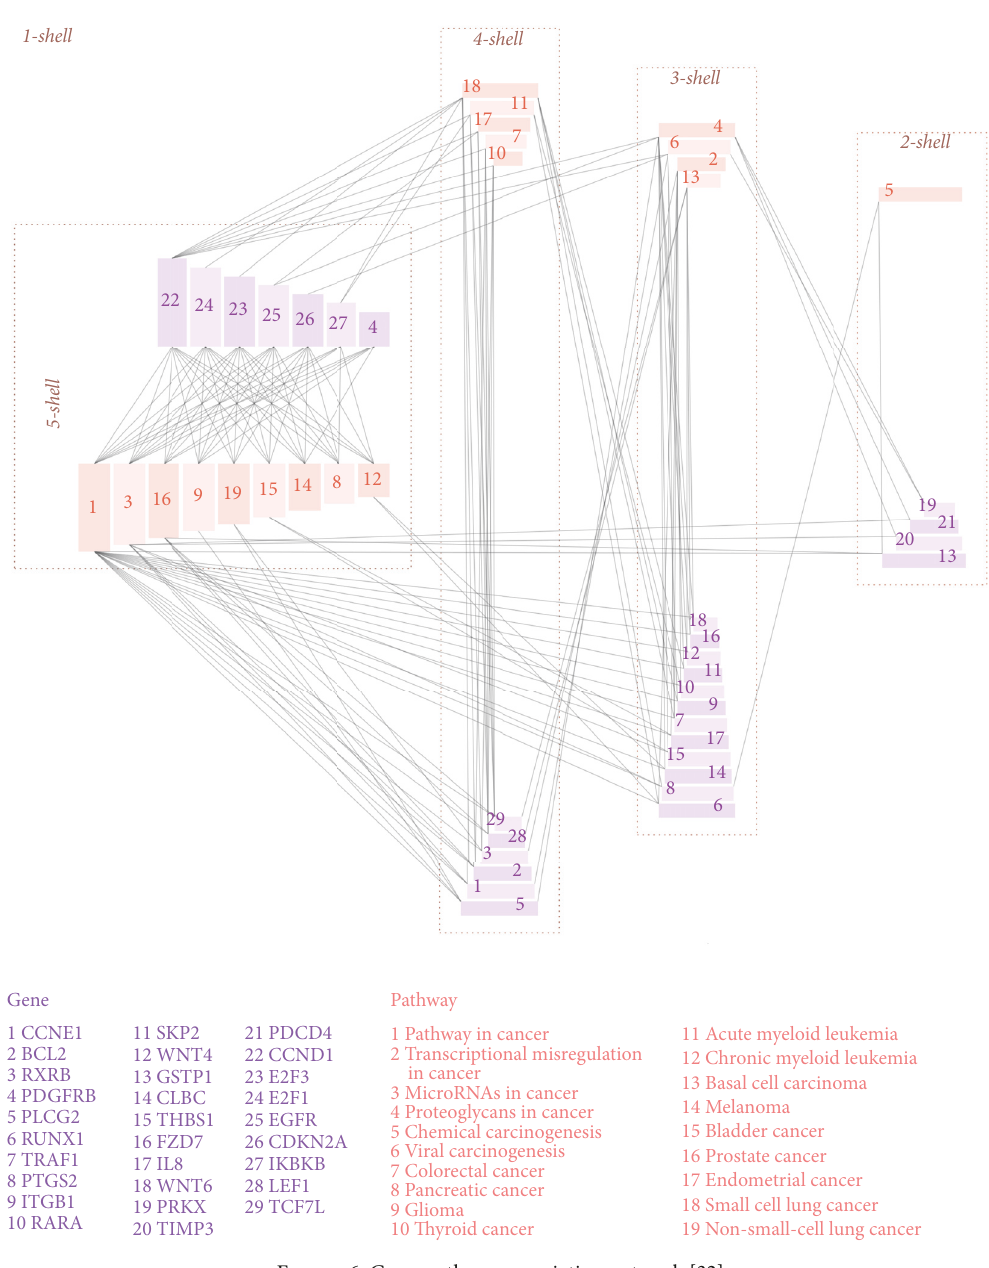
Figure 6: Gene-pathway association network